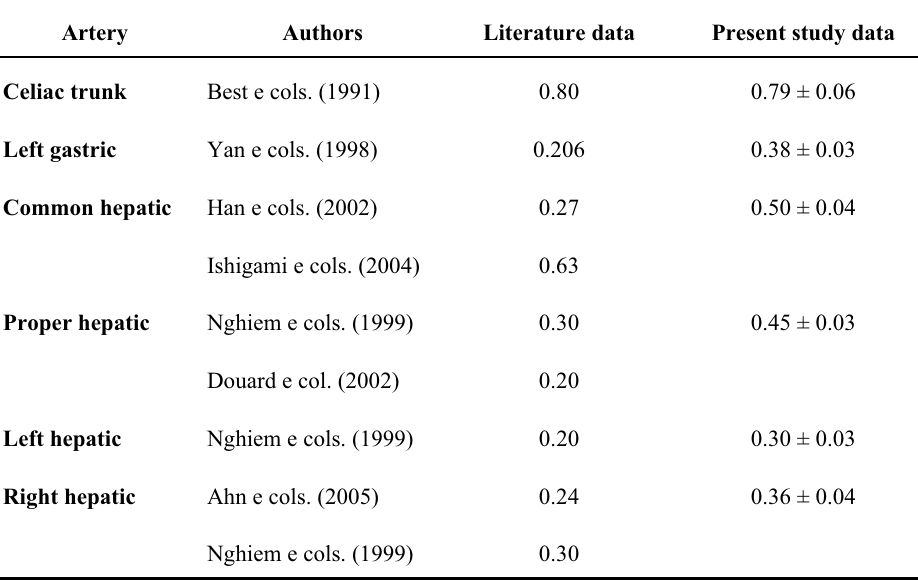
TABLE 2: Mean arterial diameter of the normal celiac trunk and main branches obtained in the present study. Comparison with data from other authors, obtained in vivo, through radiological exams. Data expressed as cm ± standard deviation of